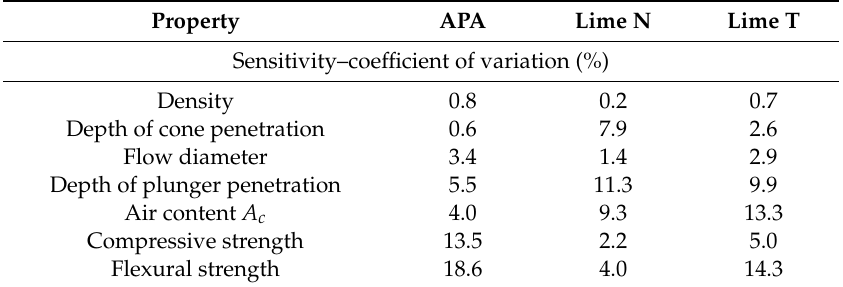
Table 19. The sensitivity of plaster properties to changes in mixing intensity.